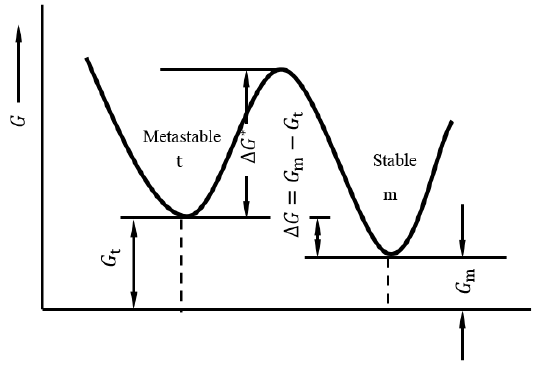
Fig. 35 Illustration of the free energy relation between metastable t-phase and stable